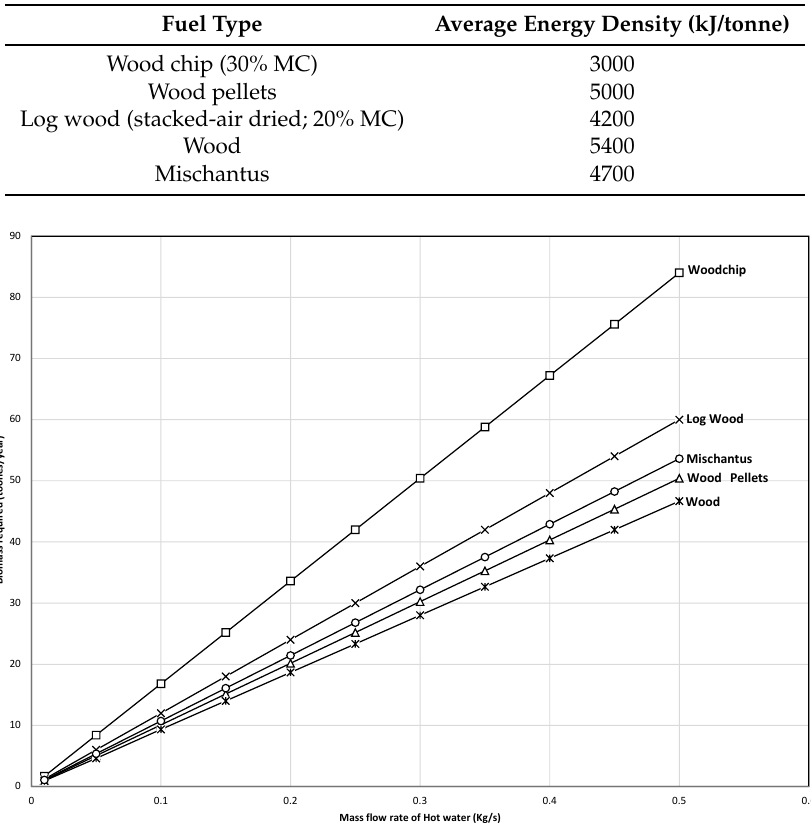
Figure 5. Effect of mass flow rate of hot water on fuel